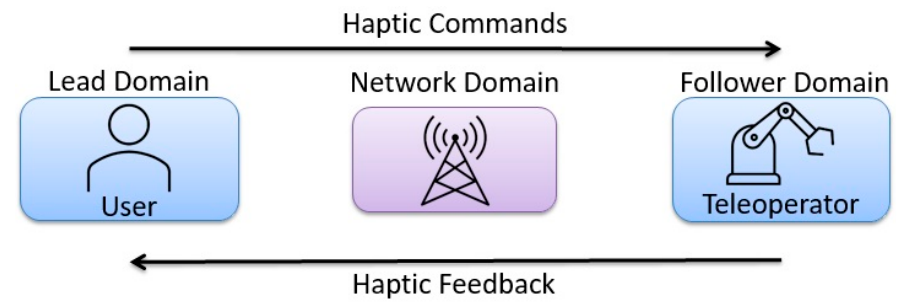
Figure 2. Tactile Internet communication domains.